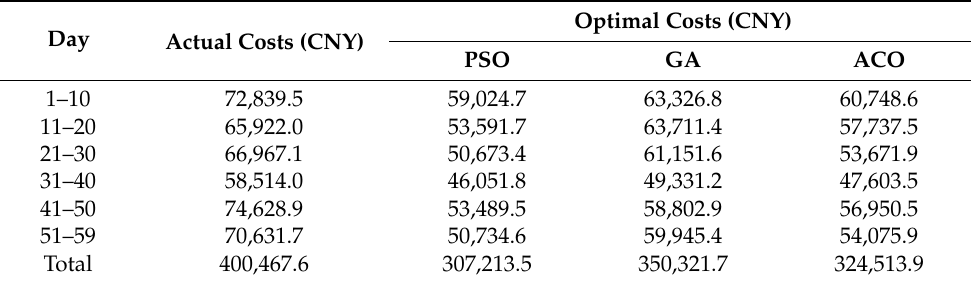
Table 3. Comparison of optimal costs of the case system calculated by three algorithms (particle swarm optimization (PSO), genetic algorithm (GA) and ant colony optimization (ACO)) for 59 d from 22 June to 19 August